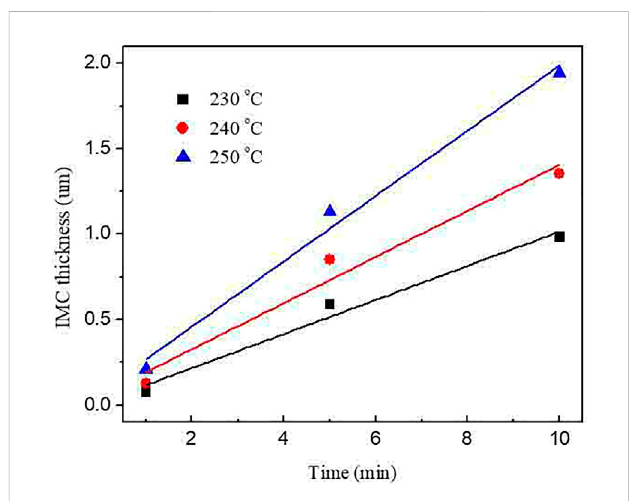
FIGURE 2 IMC thickness at interfa. ce heated at different temperature and